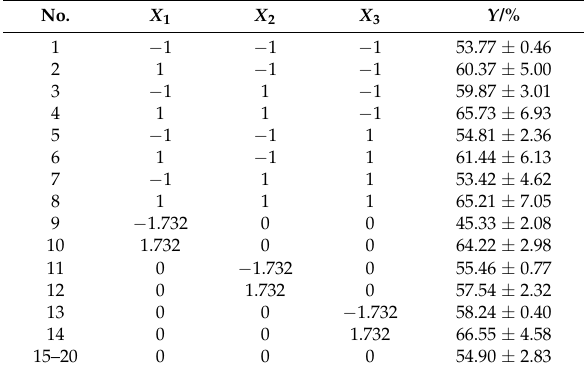
Table 1. Results of central composite design batches ( n = 3, mean ±